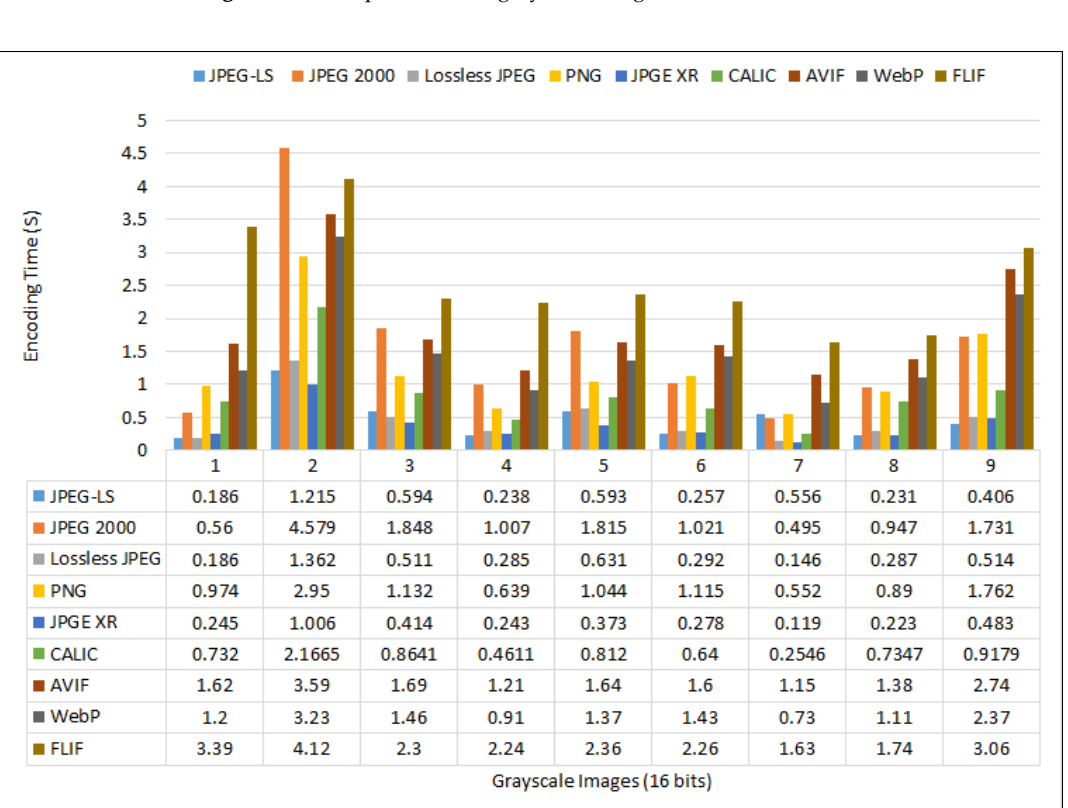
Figure 20. Examples of 16-bit greyscale images.